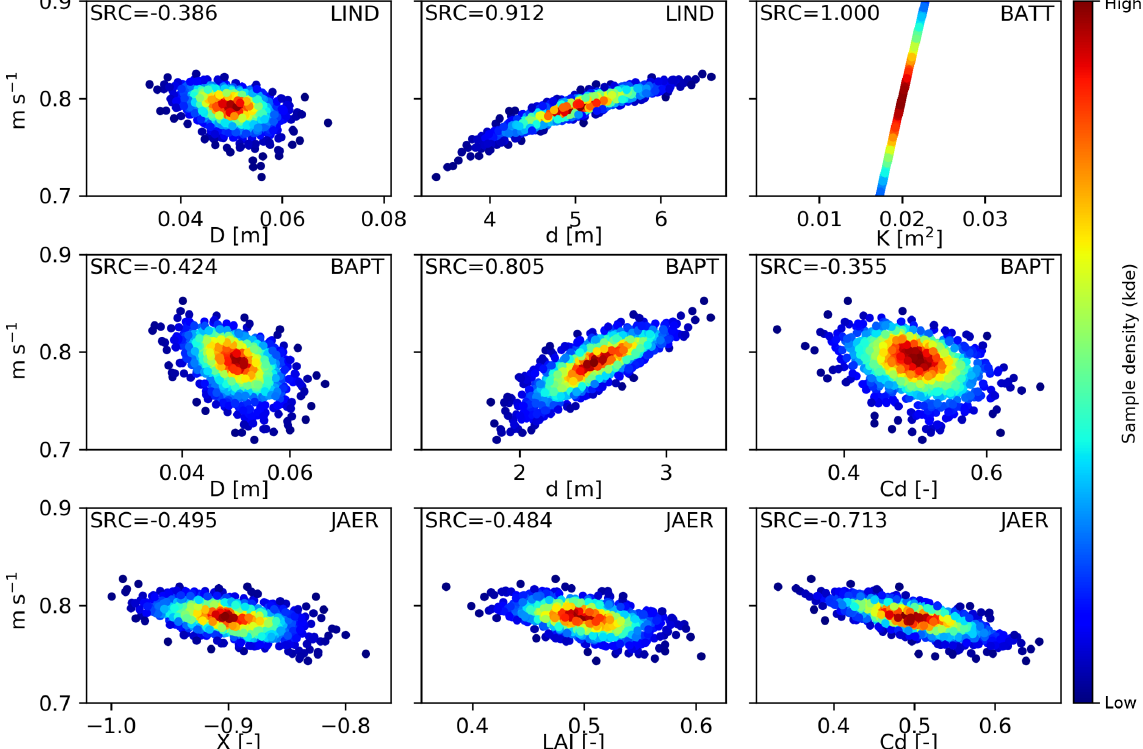
Figure 3. Scatterplots of flow velocity results against floodplain friction input parameters at node 13470.